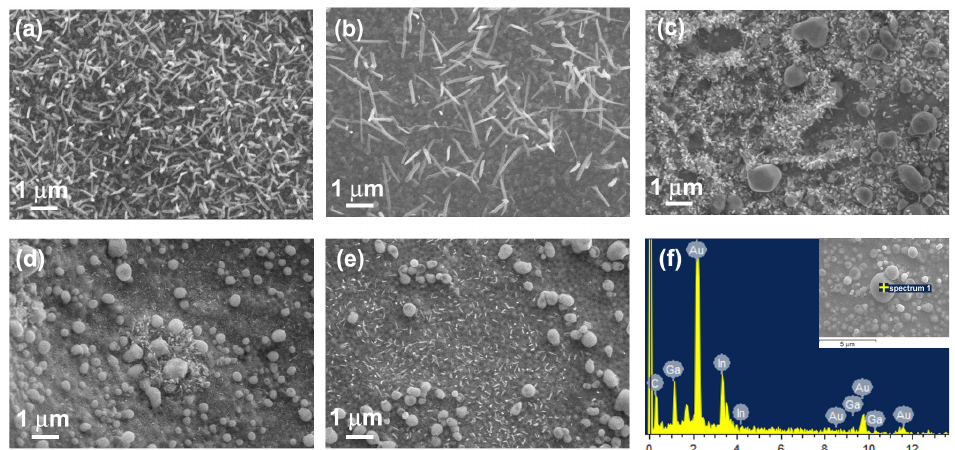
Figure 4. Top-view SEM images of the In x Ga 1−x N NWs grown on the nitrided Ta surfaces using catalysts of ( a ) Ni, ( b ) Ni1Au1, ( c ) Ni1Au2, ( d ) Ni1Au4, and ( e ) Au. ( f ) The EDS spectrum (spectrum 1) from a large particle in the inset which is the top-view SEM image of a nitrided dimpled Ta surface after CVD growth using catalysts of Ni1Au4.